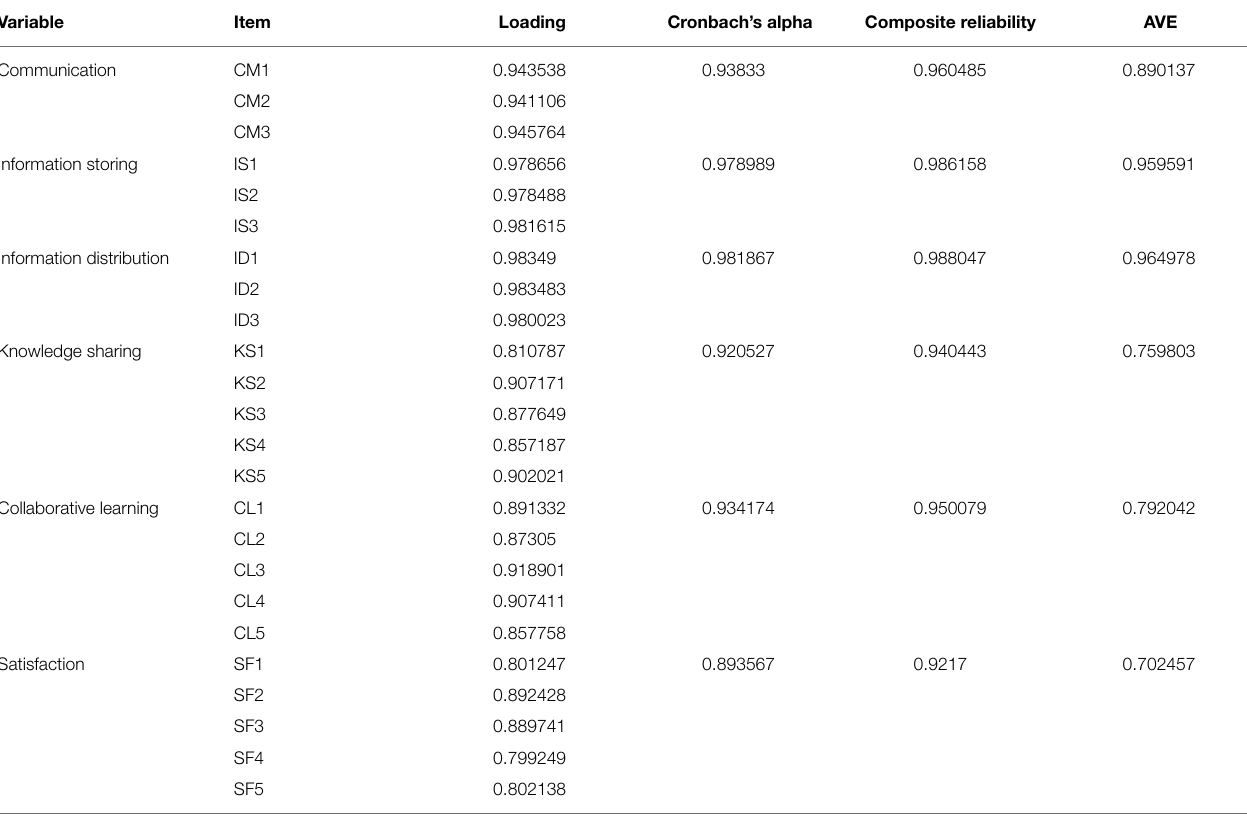
TABLE 1 | Reliability and validity test.